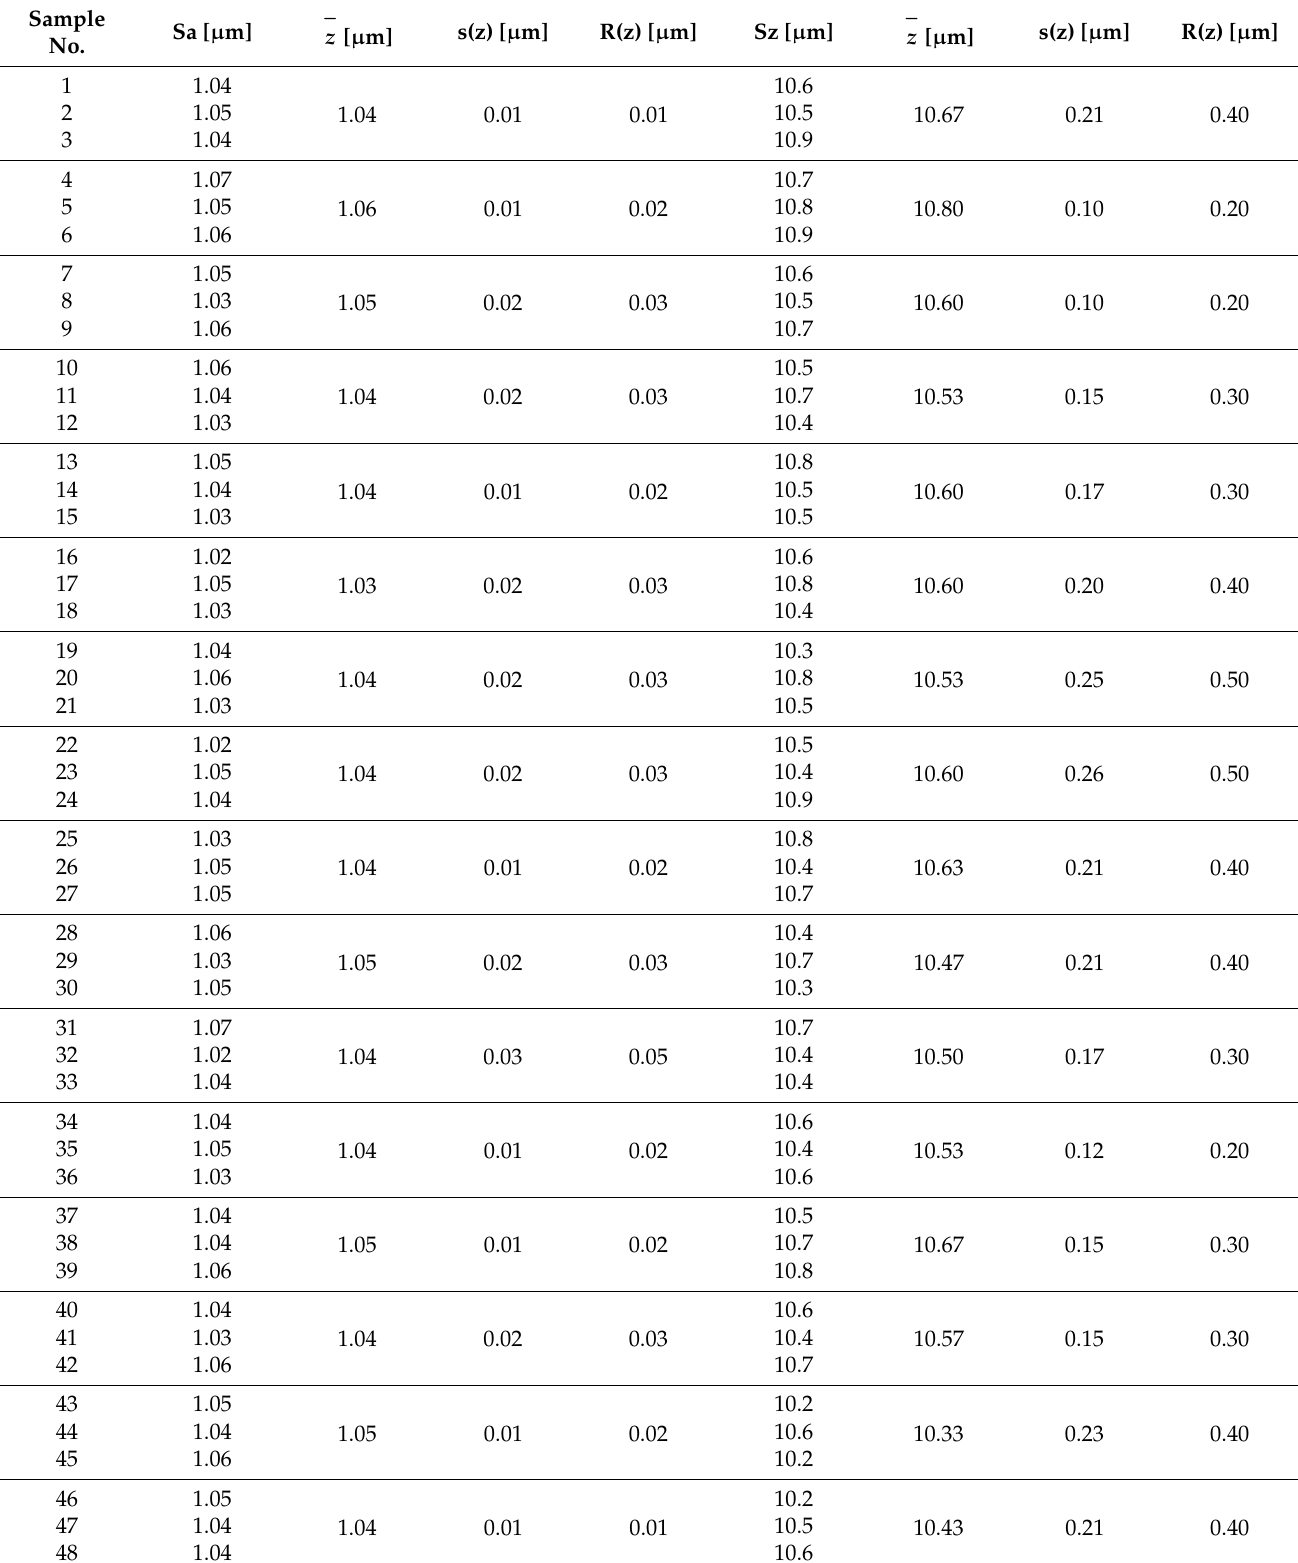
Table 7. Results of Sa and Sz measurements of PA2 aluminum alloy samples before paint